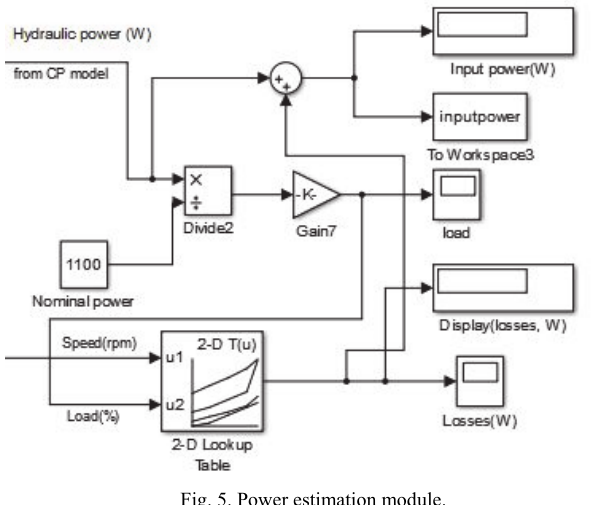
Fig. 5. Power estimation